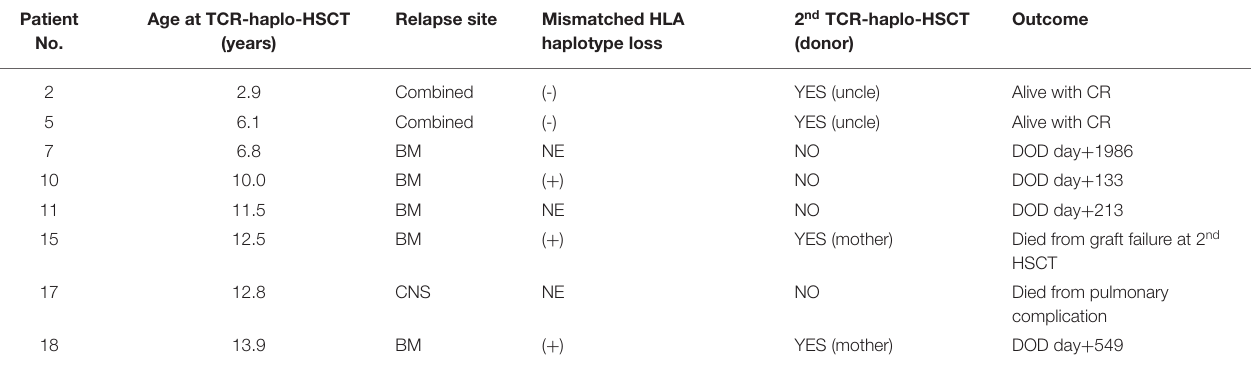
TABLE 3 | Summary of relapsed patients after T-cell replete haploidentical stem cell transplantation. Patient